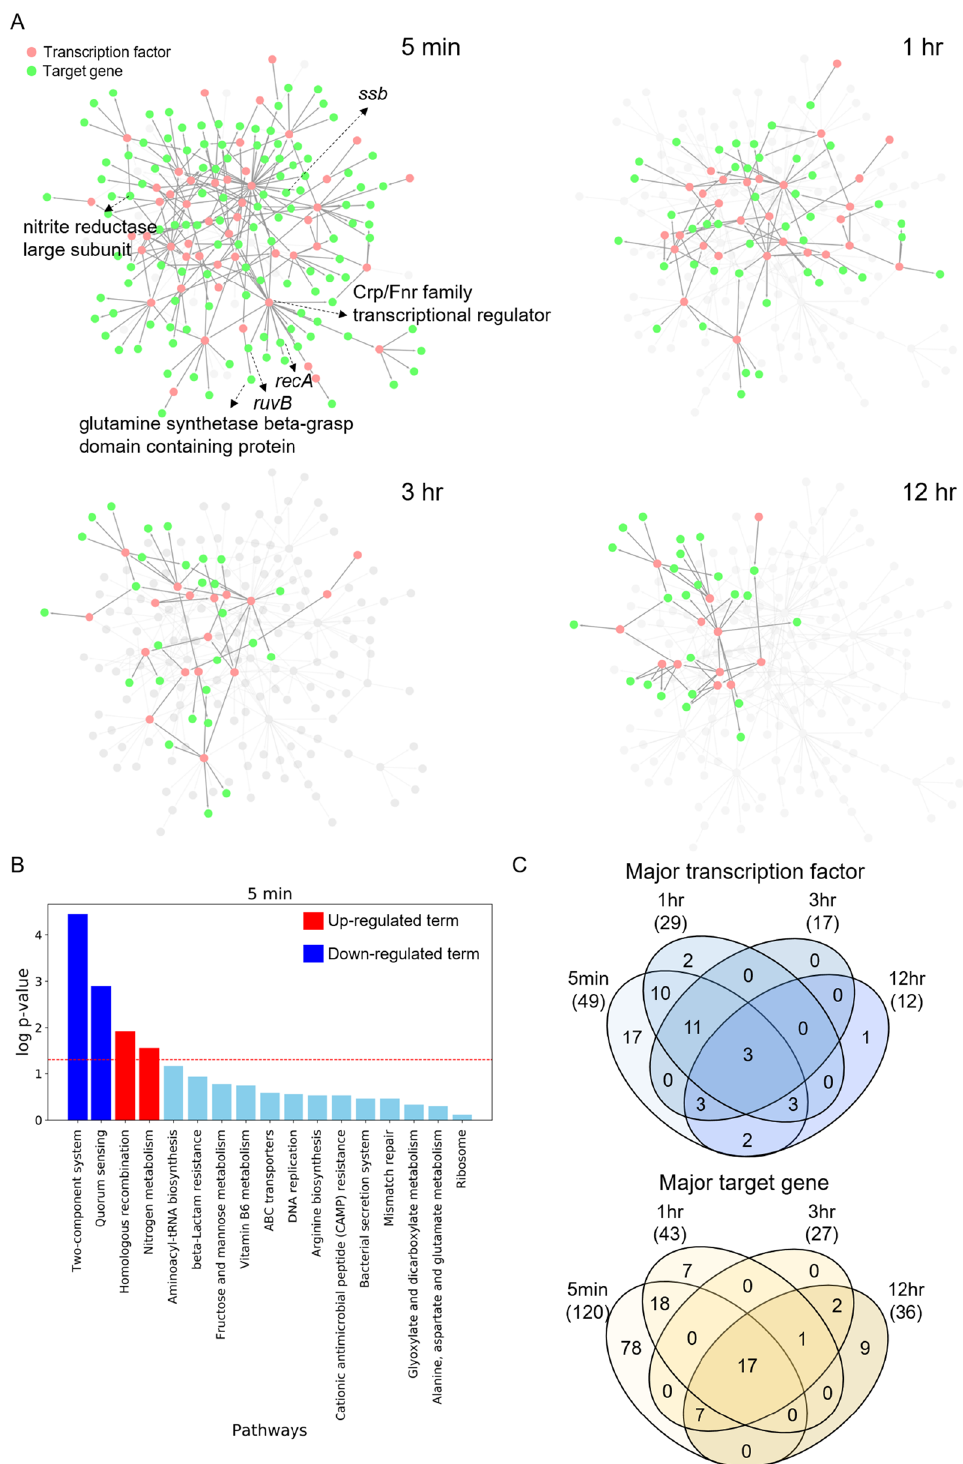
Figure 4. Transcriptional network module analysis. ( A ) Perturbation of transcriptional network module in varying time points. Major transcription factors are shown in red color and target genes are shown in green color. ( B ) Pathway enrichment analysis of genes in early response (5 min) module with KEGG pathways. Red colored bar represents up-regulated terms, blue colored bar represents down-regulated terms, and statistically insignificant terms are colored in light blue. ( C ) Venndiagrams show major transcription factors and major target genes over time identified by our